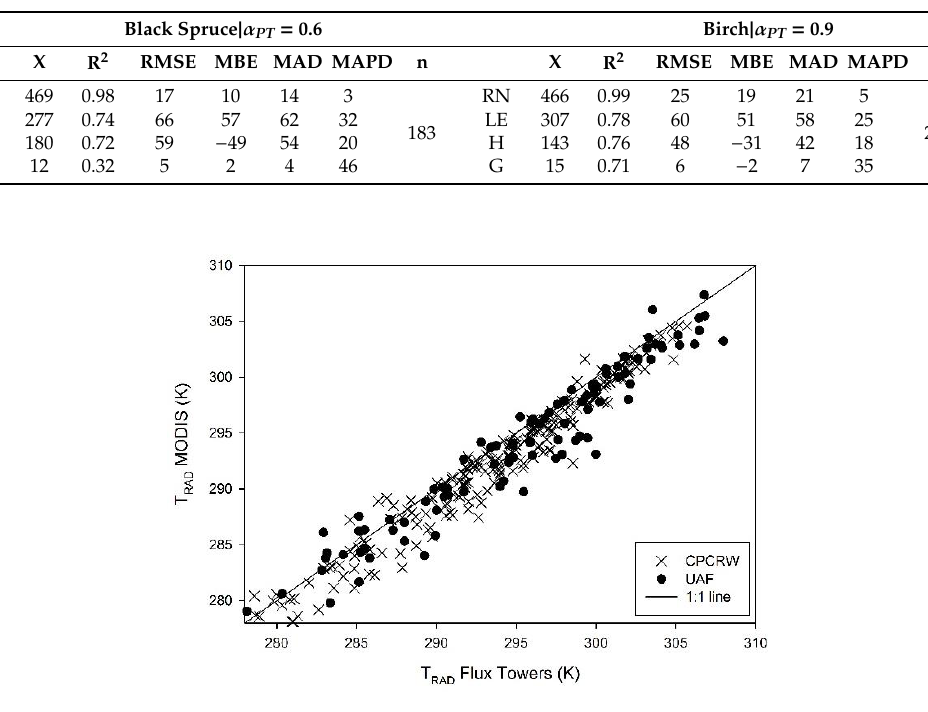
Figure 9. Comparison of remote sensing estimates of T RAD vs. at-satellite pass observed measurements of T RAD at black spruce and birch flux towers. Perfect agreement is represented by the 1:1 line.